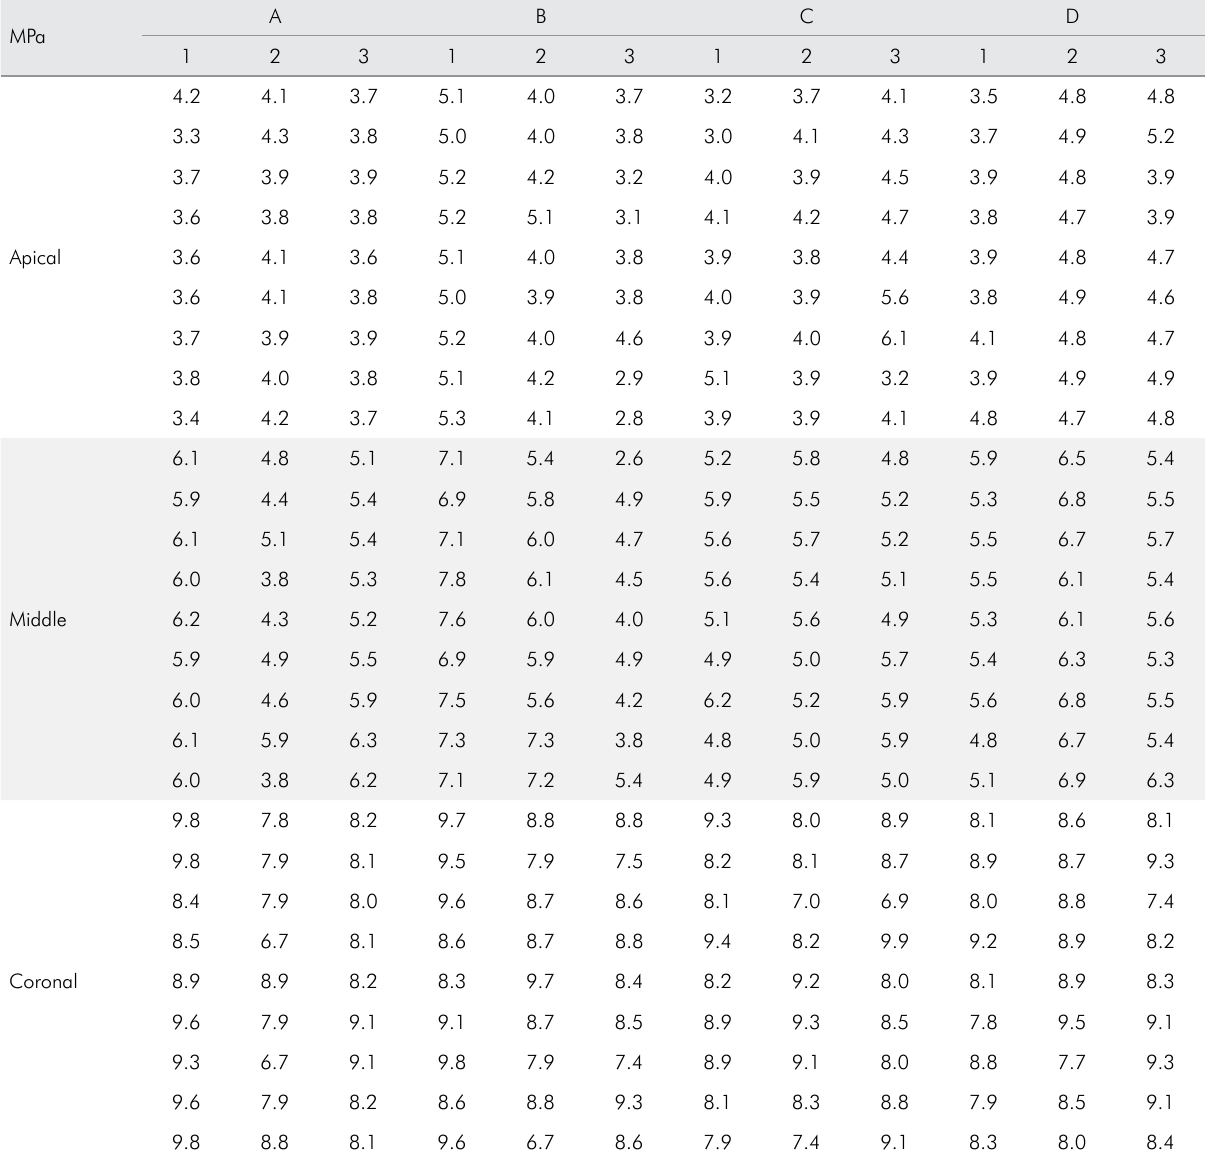
Table 2. Mean bond strengths (Mpa) of fiber post and adhesive systems. MPa